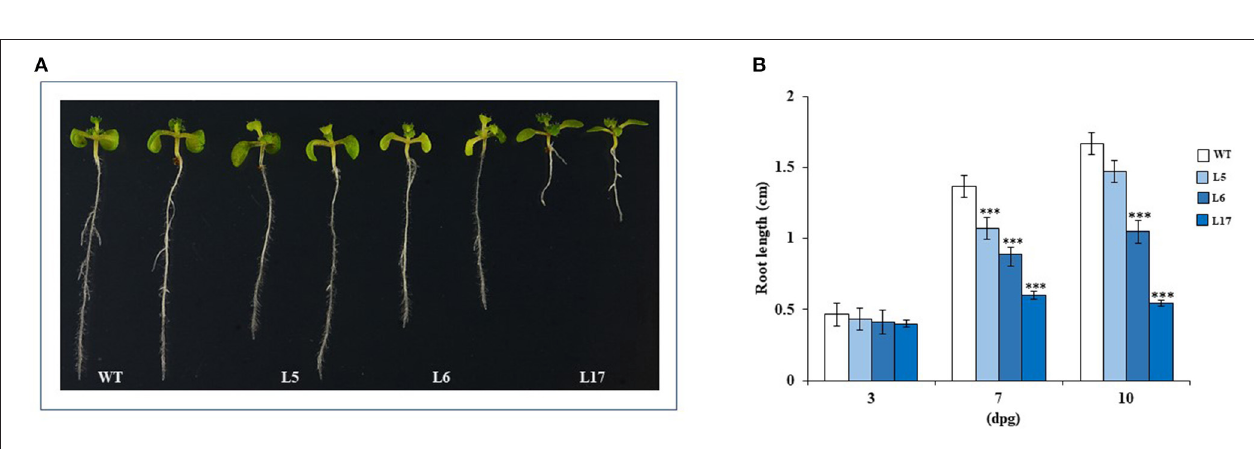
FIGURE 6 | Root elongation is negatively altered in AhN4L-1 overexpressing Arabidopsis thaliana plants. (A) Comparison of root length between three lines of AhN4L-1 transgenic plant lines (L5, L6, and L17) having significantly different transgene expression dosage and wild-type (WT) untransformed plants. Seeds of WT and transgenic plant lines were germinated and grown on MS medium for 10 days. (B) Root length was measured at 3, 7, and 10 days after germination. The bars are means ( n = 20) ± SE of three independent experiments. Asterisks over the bars denote statistically significant differences at P < 0.001 (***) (One-way ANOVA, Tukey-Kramer